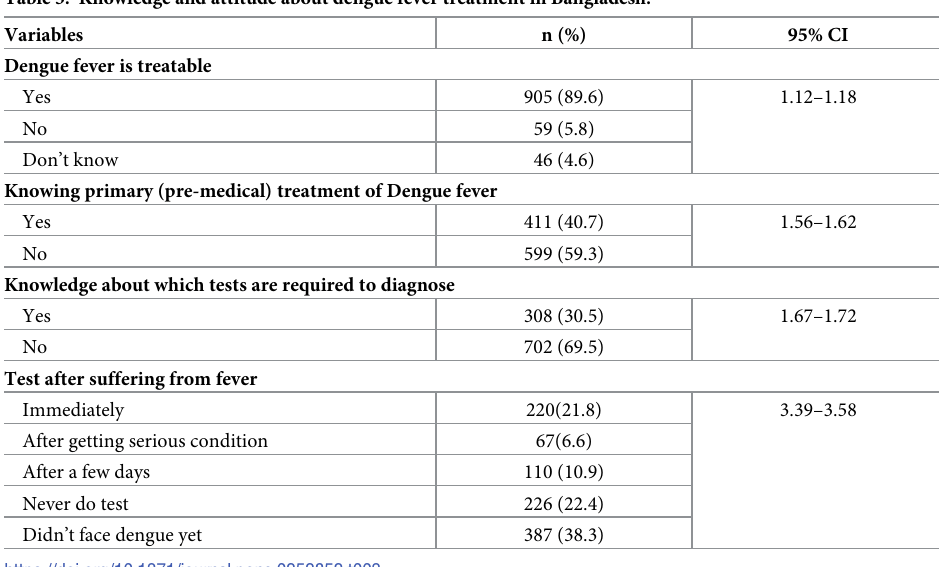
Table 3. Knowledge and attitude about dengue fever treatment in